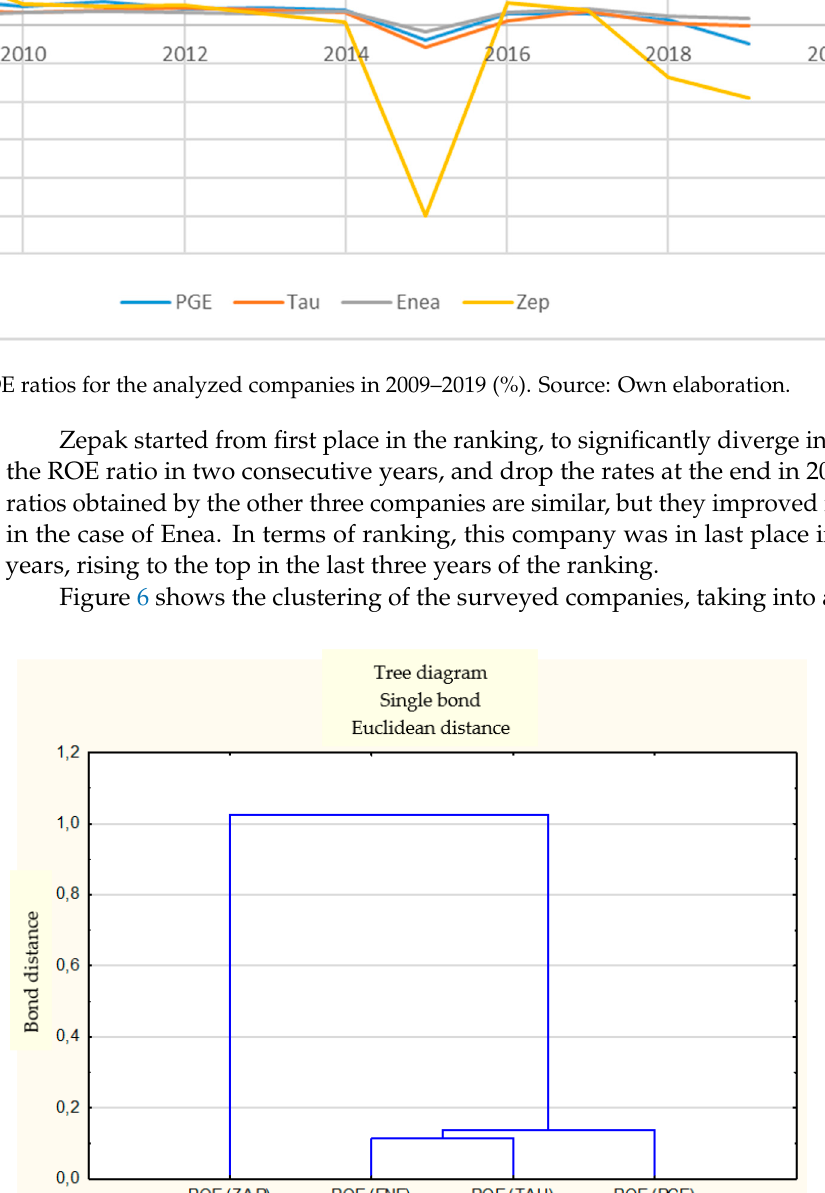
Figure 6. Dendrogram grouping the surveyed companies in terms of ROE. Source: Own elaboration. Table 3. Coefficients of variation and standard deviations for ROE of the surveyed companies.